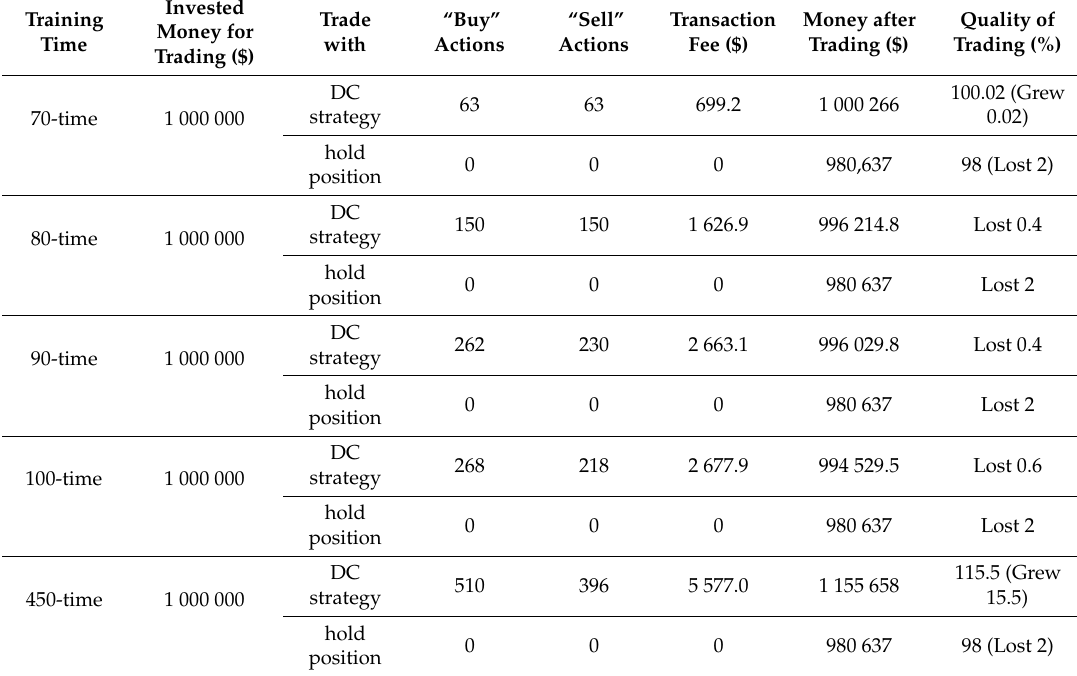
Table 3. Main information about the trading process tested with different training time.